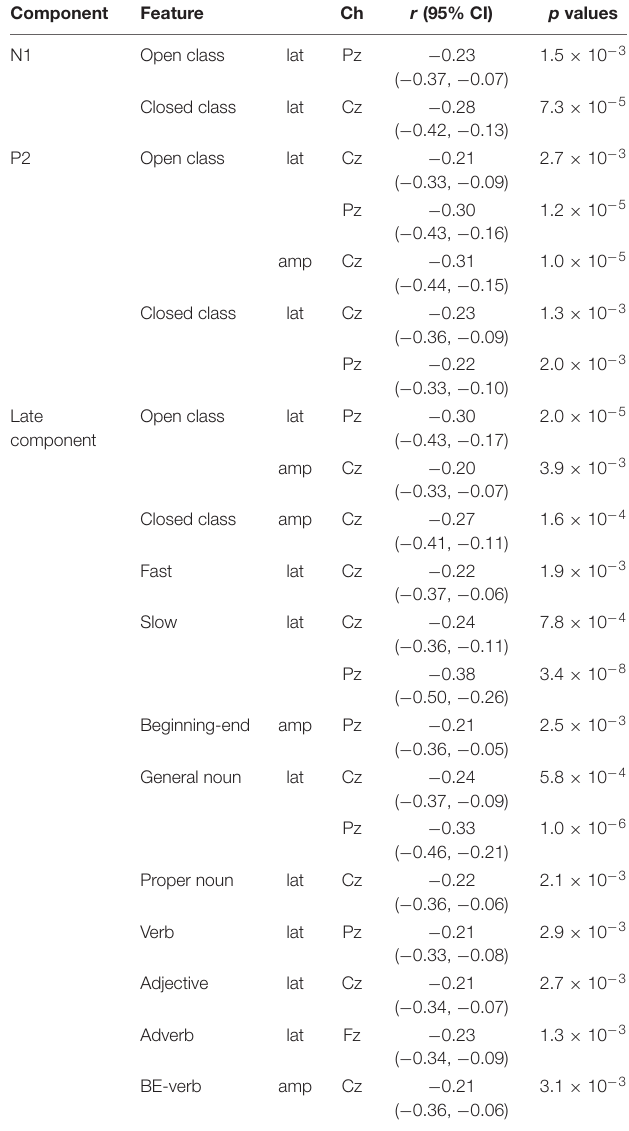
TABLE 1 | Electroencephalographical features showing correlation ( | r | > 0.2) with the listening scores. Component